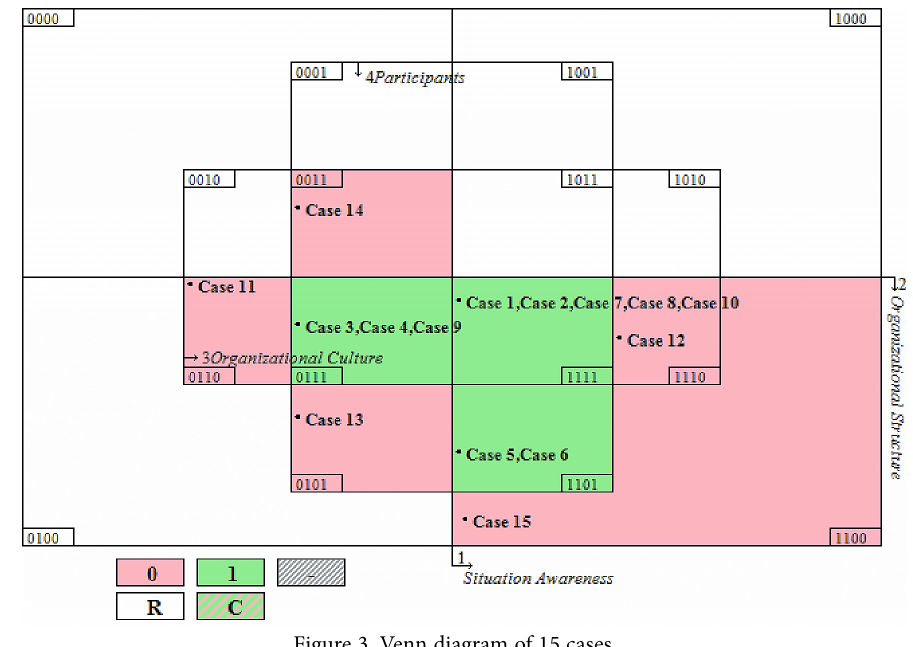
Figure 3. Venn diagram of 15 cases Table 7. Qualitative comparative analysis of conditional